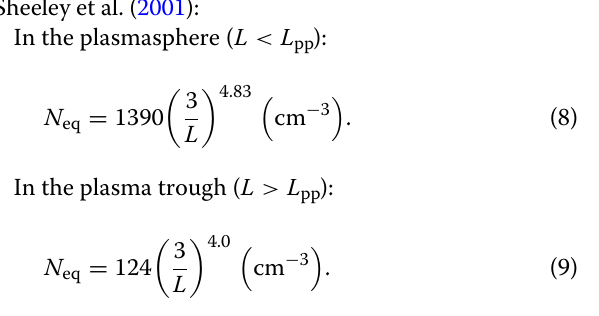
Fig. 1 Dispersion relation curves of equatorial magnetosonic waves at the wave normal angles of 87 and 89: a inside the plasmasphere at L and b outside the plasmasphere at L 6. c Wave phase velocity and d group =